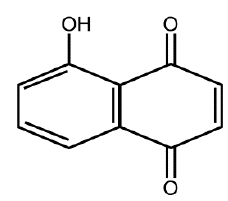
Figure 1. Molecular structure of juglone.